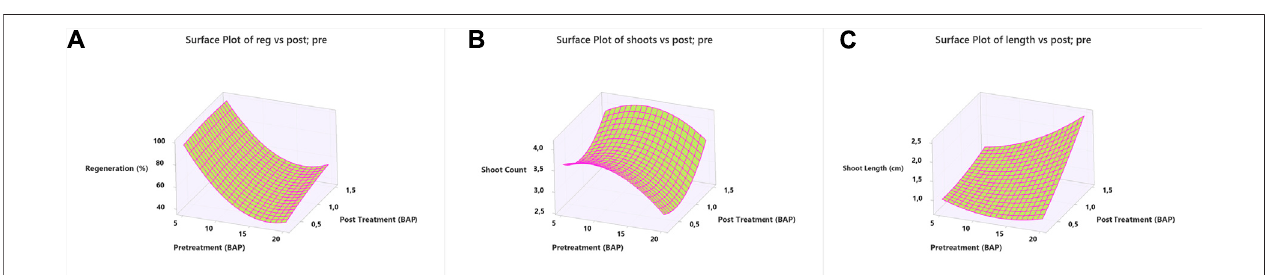
FIGURE 2 | 3D response surface plots of in vitro regeneration of common bean (A) regeneration, (B) shoot count, and (C) shoot length.